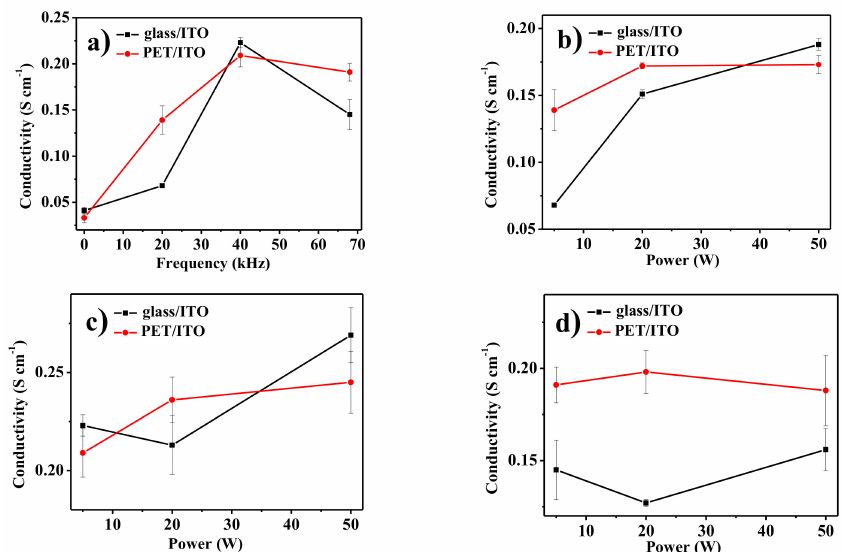
Figure 7. Conductivity of PEDOT:PSS coated on glass/ITO and PET/ITO substrates at varying frequencies and powers of vibration. ( a ) Conductivity versus frequency at 5 W, and conductivity versus power at ( b ) 20 kHz, ( c ) 40 kHz, and ( d ) 68 kHz,